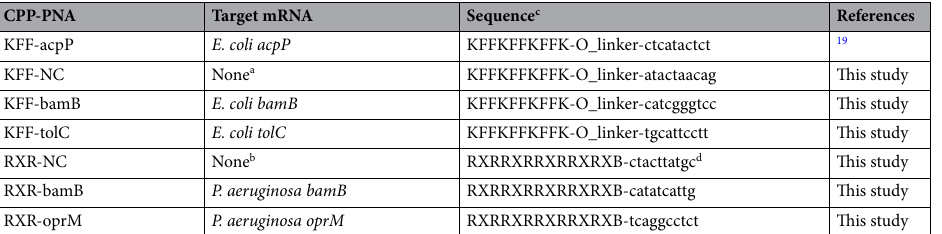
Table 3. List of CPP-PNAs used in this study. CPP-PNA, cell-penetrating peptide conjugate of peptide nucleic acid; acpP , a gene for acyl carrier protein AcpP; bamB , a gene for outer membrane lipoprotein BamB; tolC , a gene for outer membrane efflux protein TolC; oprM , a gene for outer membrane protein OprM. a No match with E. coli MG1655 genome as antisense. b No match with P. aeruginosa PAO1 genome as antisense. c Uppercase and lowercase letters indicate peptide and PNA sequences, respectively, and PNA sequences are shown from the N-terminus to the C-terminus. The O_linker portion is composed of polyethylene glycol. d X and B indicate 6-aminohexanoic acid and beta-alanine residues,